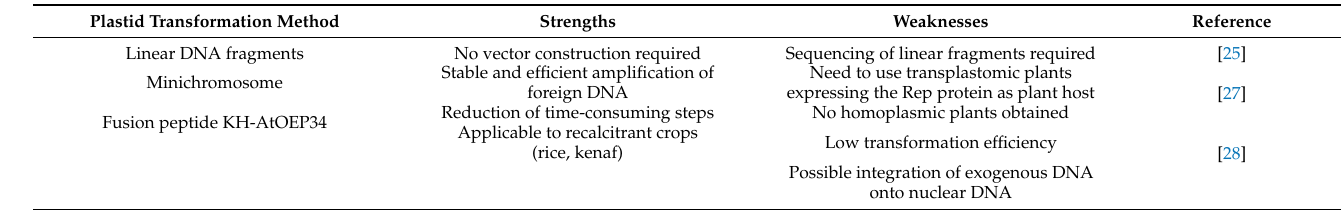
Table 1. Strengths and weaknesses of new plastid transformation